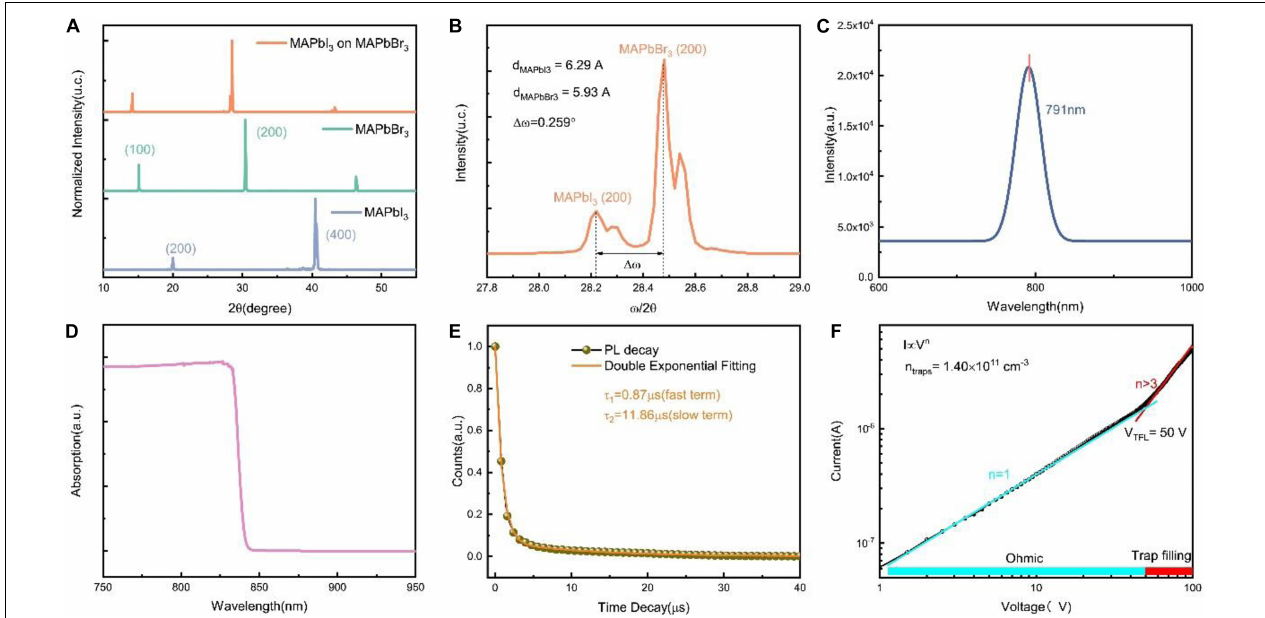
FIGURE 2 | (A) XRD spectra of the epitaxial MAPbI 3 SCF on MAPbBr 3 , MAPbBr 3 PSC, and MAPbI 3 PSC. (B) XRD spectra of the epitaxial MAPbI 3 SCF on MAPbBr 3 at Bragg angle from 27.8 ◦ to 29.0 ◦ . (C) Photoluminescence (PL) spectra of the epitaxial MAPbI 3 SCF on MAPbBr 3 at room temperature. The PL excitation wavelength is 450 nm. (D) Absorption spectra of the epitaxial MAPbI 3 SCF. (E) Time-resolved PL spectra of MAPbI 3 SCF on MAPbBr 3 at the peak emission wavelength of 791 nm. (F) Current-voltage curve for the epitaxial MAPbI 3 based structure.